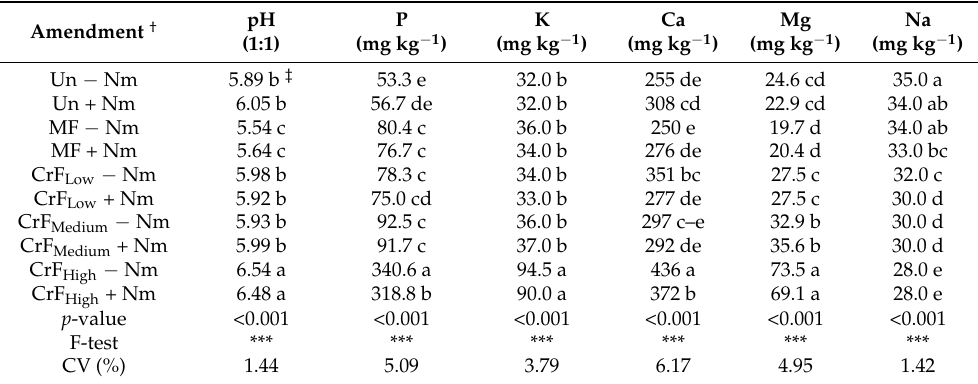
Table 5. Soil chemical properties as affected by the combined uses of different rates of cricket frass and neem seed extract.